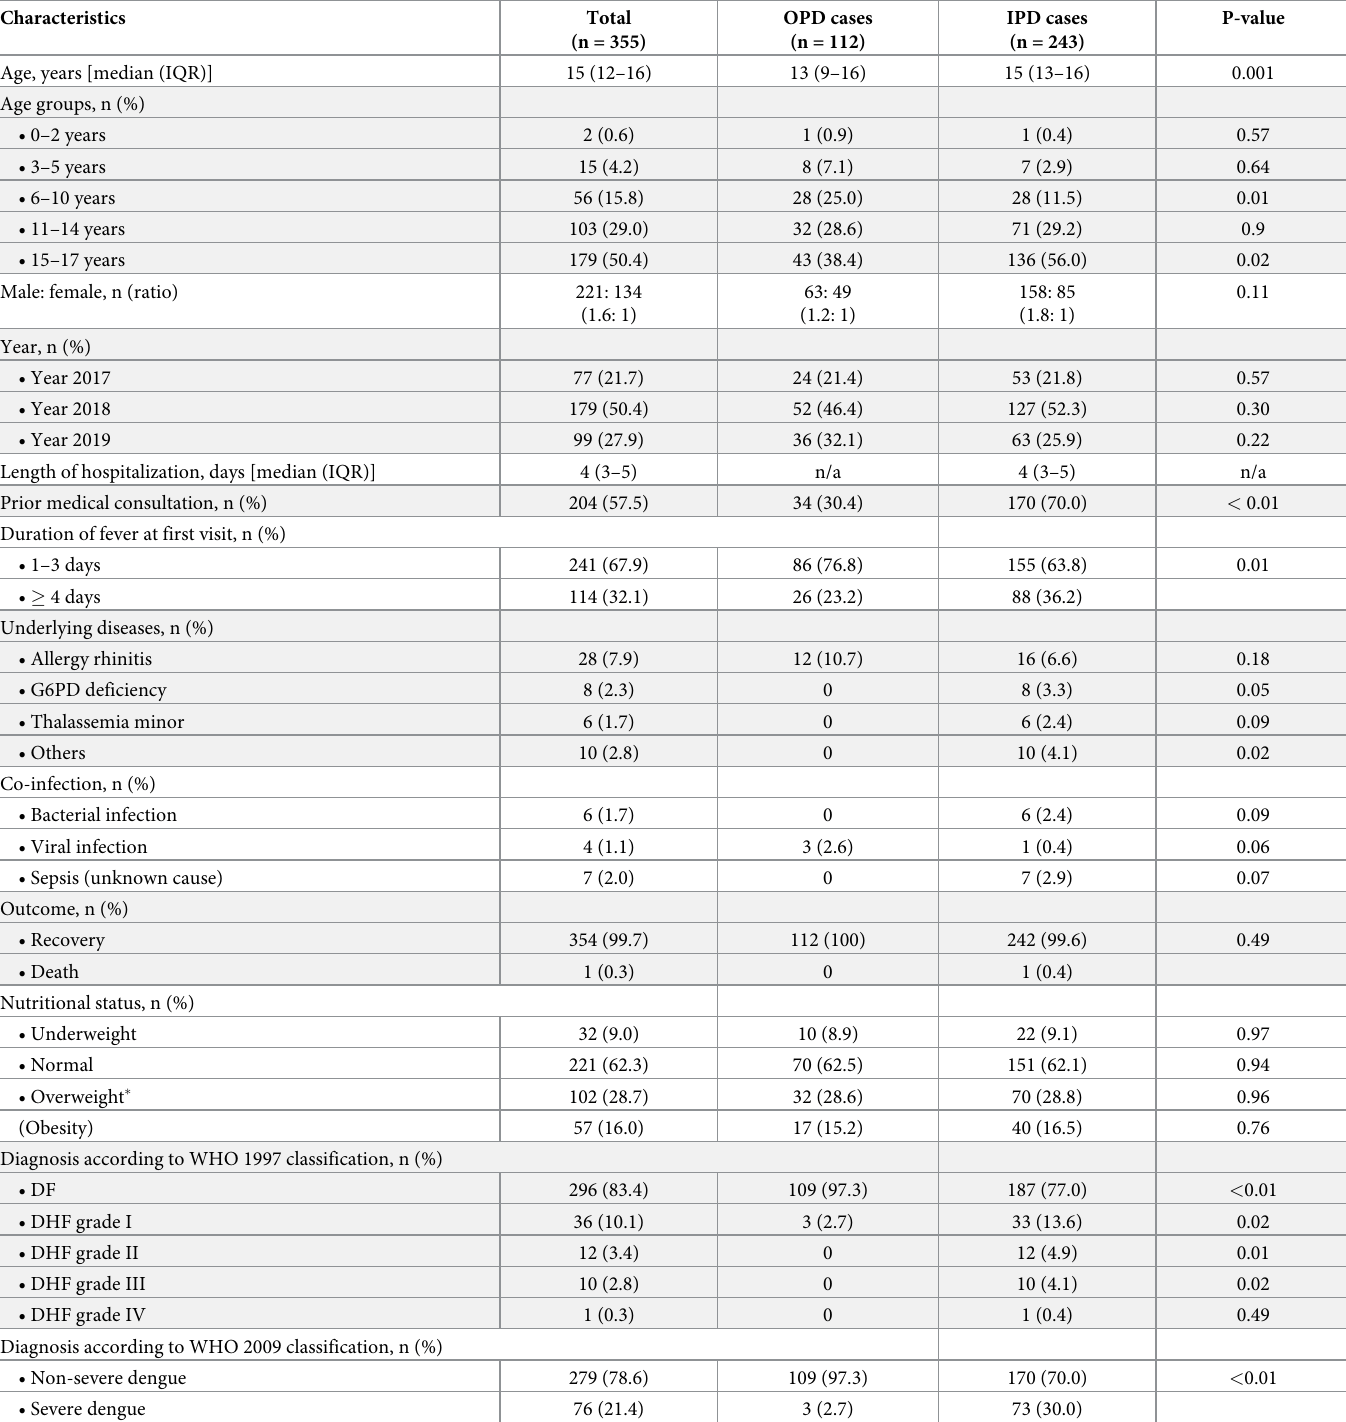
Table 1. Demographic data, nutritional status and dengue clinical classifications.